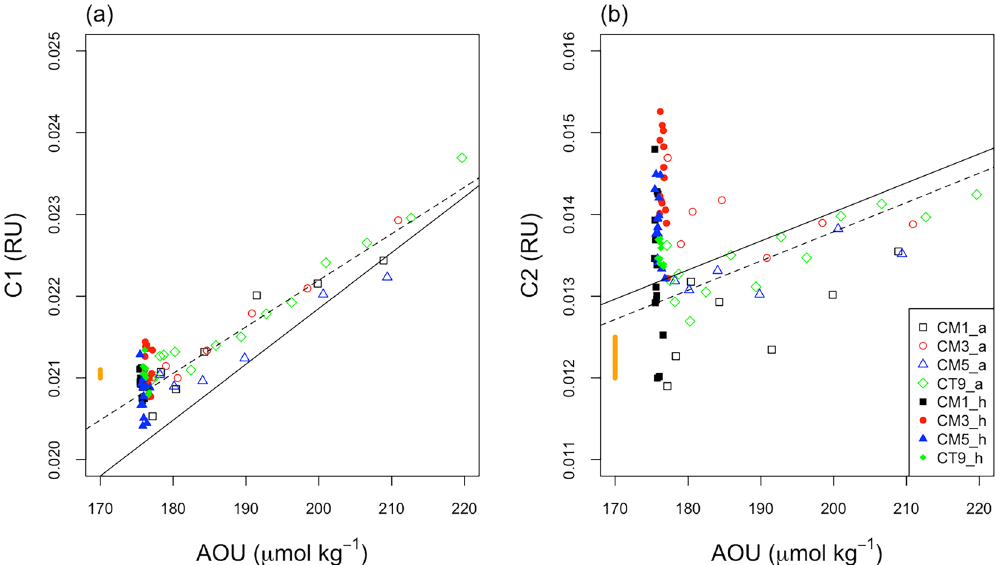
Figure 4. Scatter plots ( a ) between AOU (μmol kg −1 ) and humic-like FDOM C1 (RU), and ( b ) between AOU (μmol kg −1 ) and humic-like FDOM C2 (RU). The open symbols indicate the upper abyssal waters (> 2500 m), and solid symbols indicate the hadal waters. The yellow vertical line in each figure represents the measurement precision of C1 or C2, which was estimated from the standard deviation of the duplicate measurements. The black solid and dashed lines are the regression lines for the data obtained in the depth range of 200–6000 m (C1 = 0.0082 + 6.8 × 10 −5 AOU, r 2 = 0.98, p < 0.001; C2 = 0.0069 + 3.6 × 10 −5 AOU, r 2 = 0.86, p < 0.001 ) and 1000– 6000 m (C1 = 0.0108 + 5.7 × 10 −5 AOU, r 2 = 0.99 , p < 0.001; C2 = 0.0066 + 3.6 × 10 −5 AOU, r 2 = 0.80 , p < 0.001), respectively.